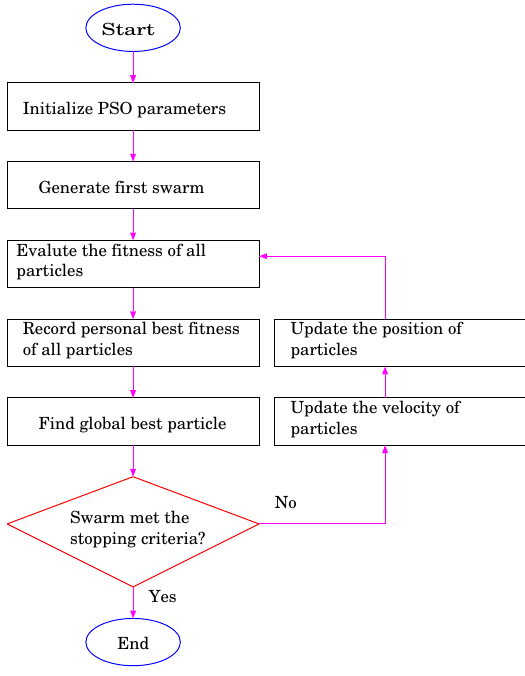
Figure 6. Standard flowchart of